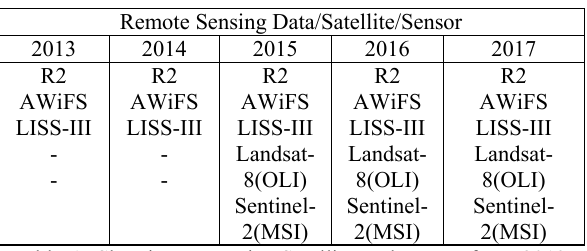
Table 1. Showing year-wise Satellite and sensor from 2013 to